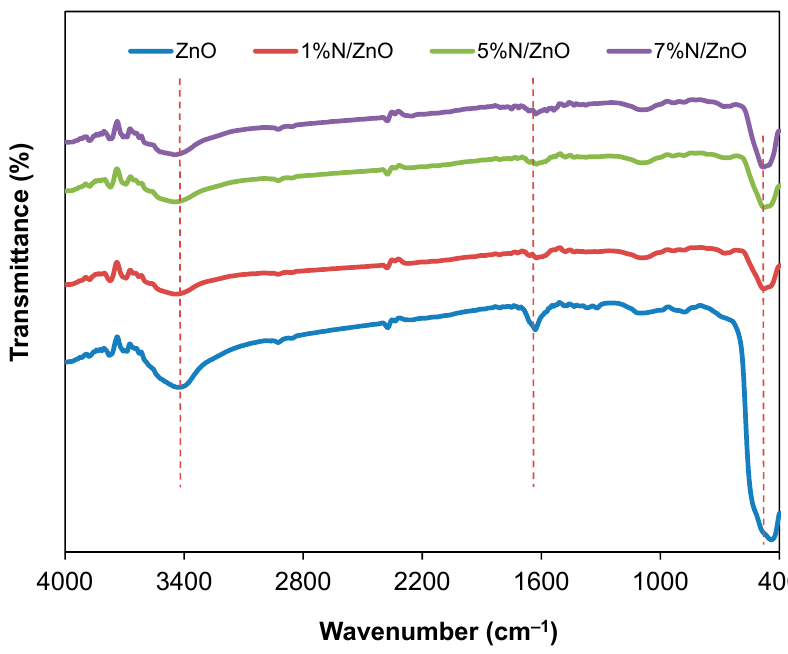
Figure 4. FTIR spectra of undoped and N-doped ZnO nanocomposites.